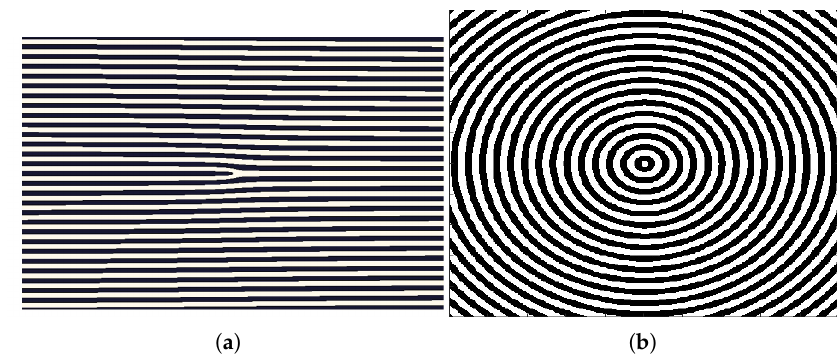
Figure 2. Intensity distributions of ( a ) fork grating and ( b ) diffractive axicon.